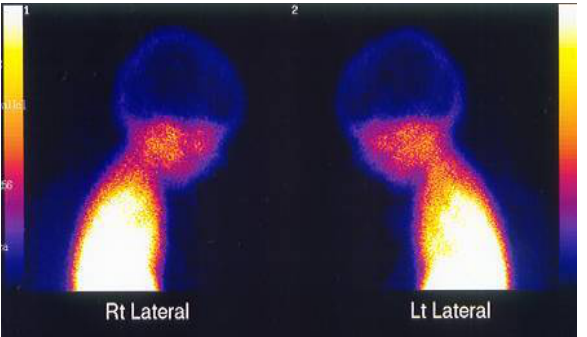
Figure 3. TC 99 scan of the brain of a brain-dead person showing nil evidence of brain activities. Photo Source: Australian Donor Awareness Programme and Training (ADAPT).